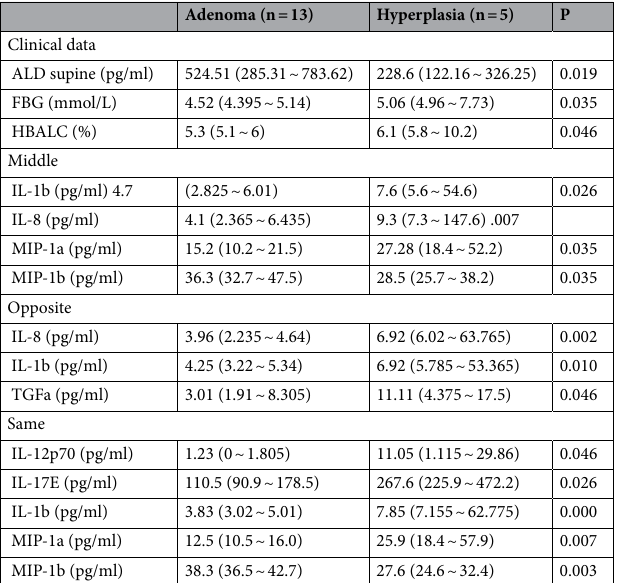
Figure 3. HE staining of the UPA patients. Scale bar, 50 μm. ( a ) The pathological result of part APA patients. ( b ) The pathological result of part UAH patients. Adenoma (n = 13) Hyperplasia (n =